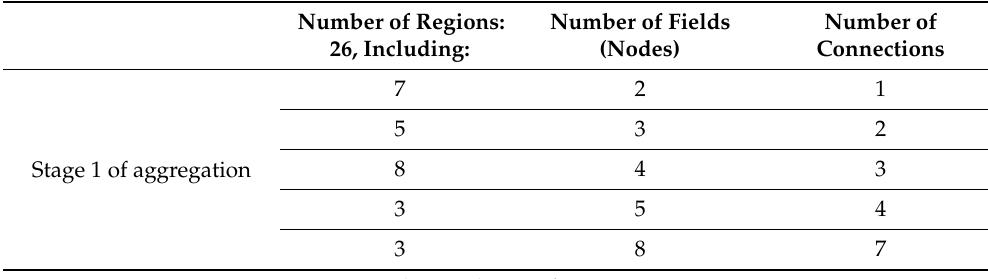
Table 2. Characteristics of the structure of networks formed according to the minimum value difference path.